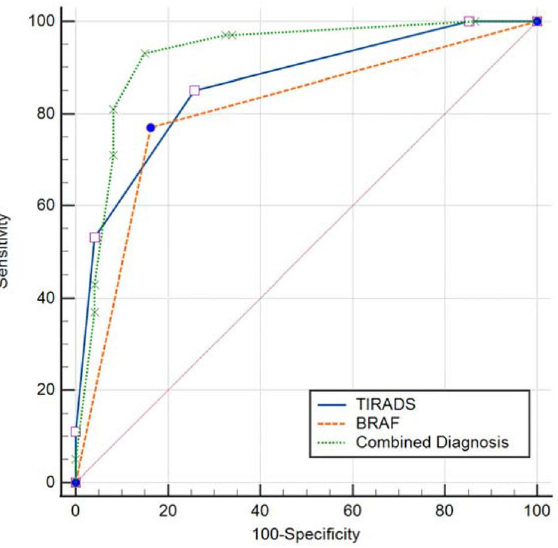
Figure 3. The AUC of combined diagnosis, TIRADS, BRAF V600E : 0.925, 0.861, and 0.804( p < 0.05).